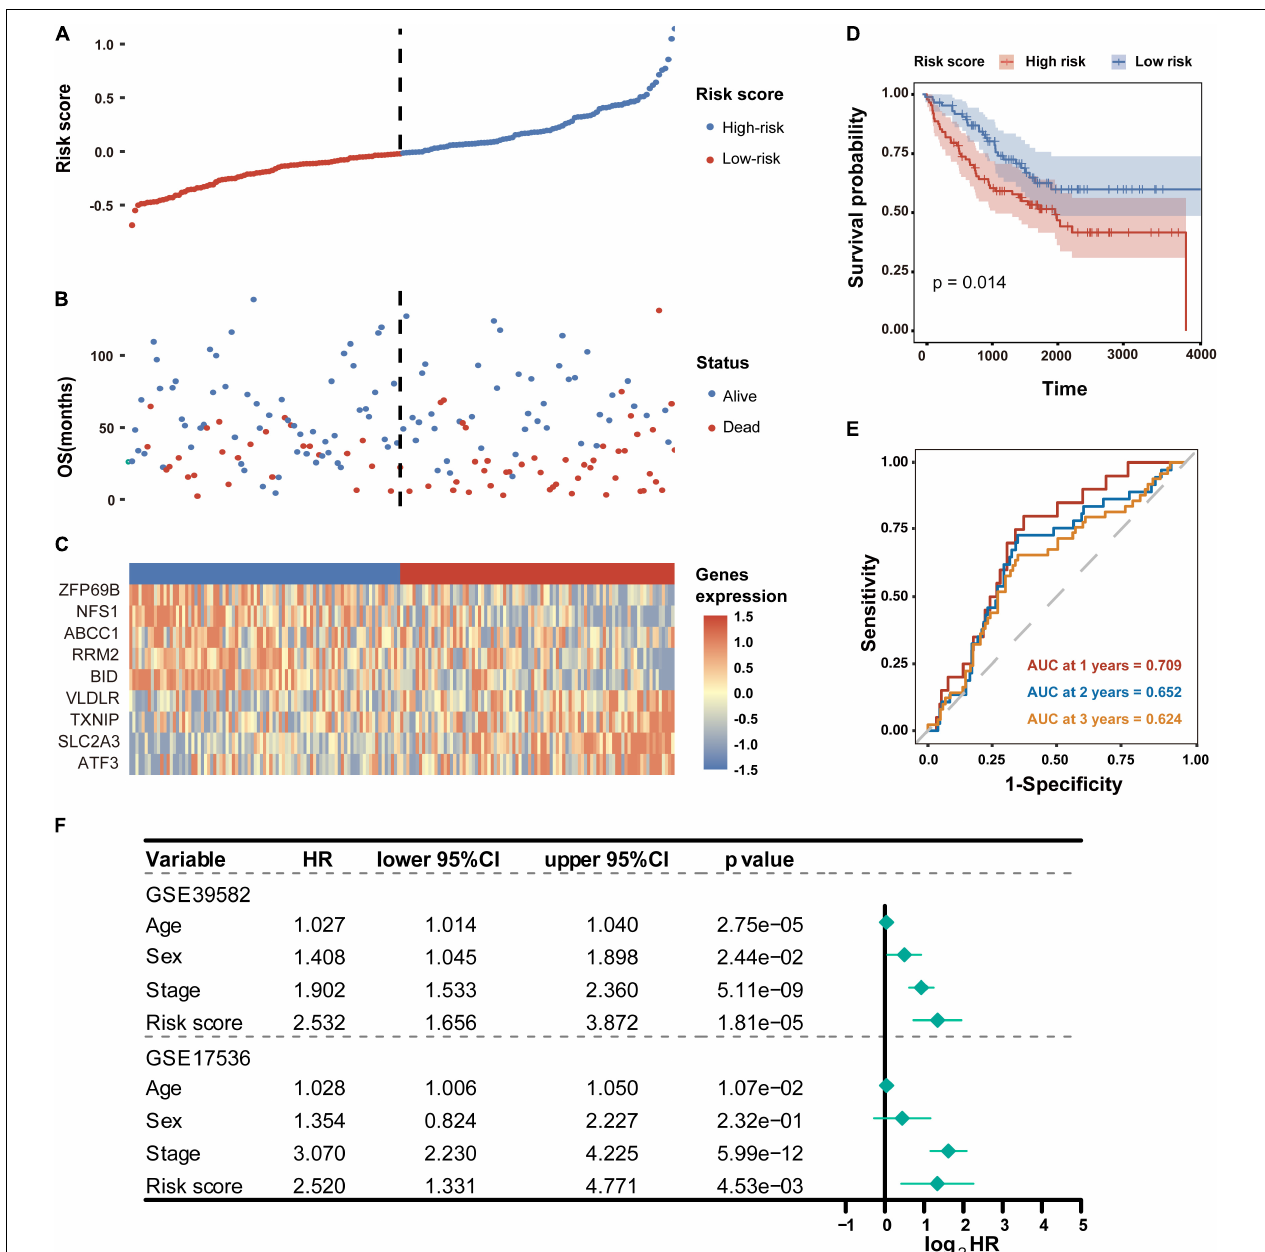
FIGURE 5 | Validation of the FRG prognostic signature in the GSE17536 dataset. (A) Distribution of risk scores based on the FRG prognostic signature in the GSE17536 dataset. (B) Survival status of CC patients with high or low risk scores in the GSE17536 dataset. (C) Heatmap shows the expression pattern of nine FRGs that constitute the prognostic signature in the GSE17536 dataset. (D) Kaplan-Meier plot for overall survival of CC patients in high- and low-risk groups in the GSE17536 dataset. (E) Time-dependent ROC curves for the prognostic performance of the FRG signature in the GSE17536 dataset. (F) Multivariate Cox regression analyses evaluated the prognostic independence of the FRG signature regarding overall survival in GSE39582 and GSE17536 datasets. HR, hazard